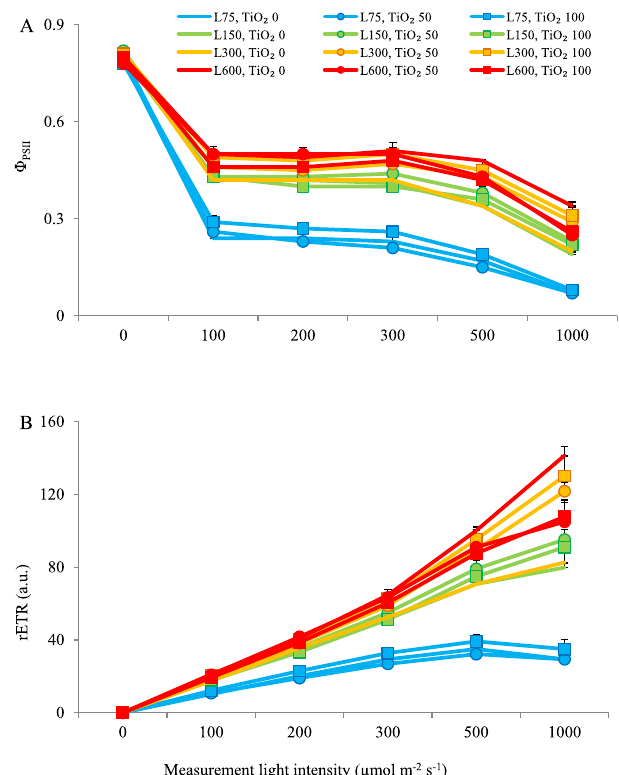
Figure 10. Rapid light curve of effective quantum yield of PSII (Φ PSII , A ) and electron transport rate (rETR, B ) (equations and explanations in Table 3) as a function of measurement light intensity in radish cv. Cherry belle plants cultivated under different light intensities (75, 150, 300 and 600 µmol m −2 s −1 ) and sprayed (once a week, and three times in total) with titanium dioxide (TiO 2 ) nanoparticles at different concentrations (0, 50 and 100 µmol L −1 ). Nine replicate plants were assessed per treatment. Bars represent SEM.